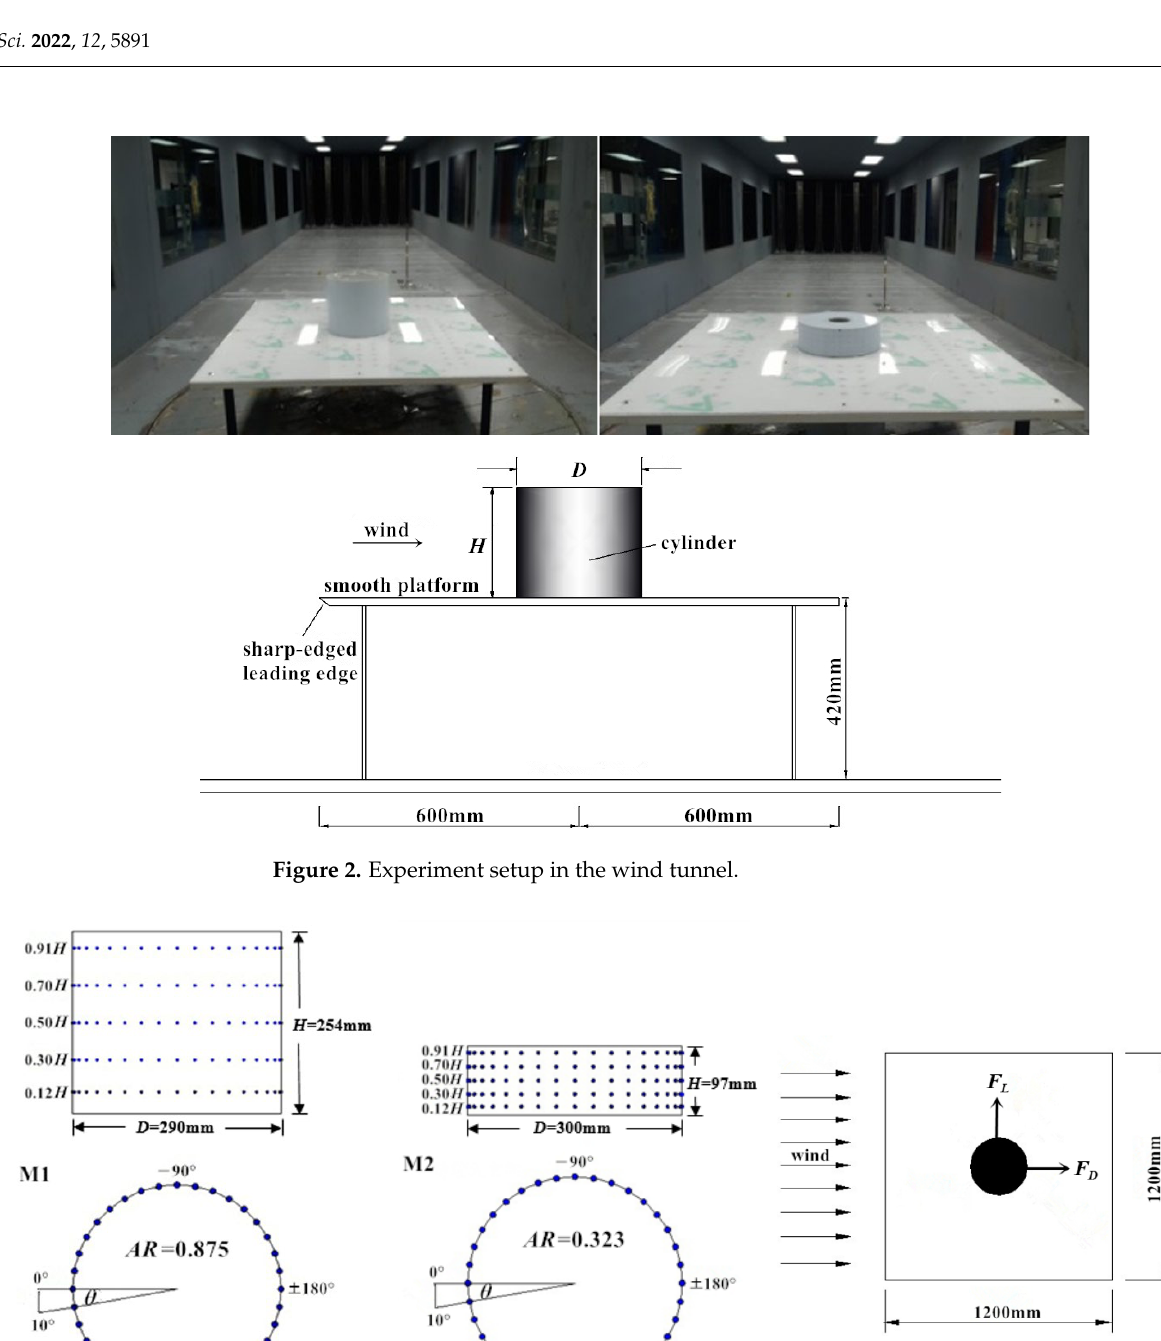
Figure 3. Test models and taps distribution.